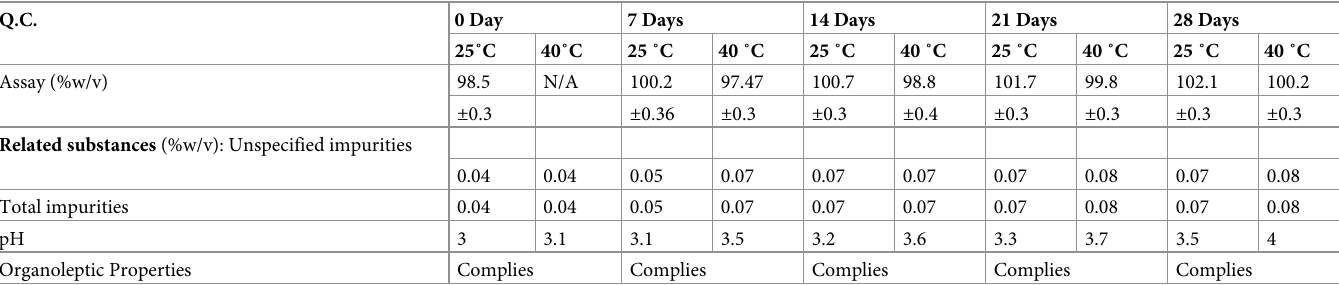
Table 2. Quality control tests for solutions from pure powder.